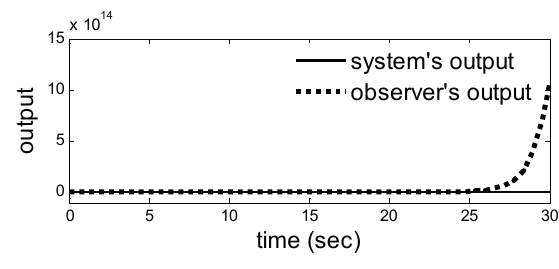
Figure 7. The outputs when a = 1 and b =